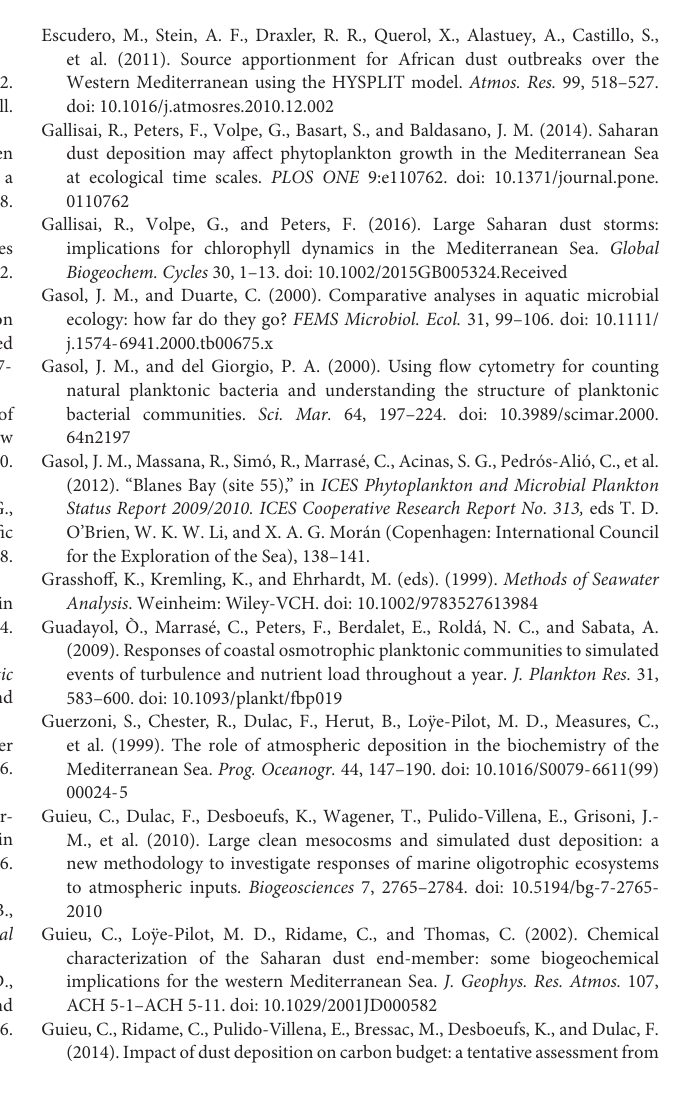
FIGURE S1 | Changes in the excitation (Ex)–emission (Em) matrixes of FDOM after the aerosol addition in the six experiments. The value of florescence before the addition in all the microcosm – expressed in quinine sulfate units (QSU) – is the same than in the C, whereas A and S matrixes show the values after the additions. The different peaks are indicated: Peak-C (terrestrial-like substances), Peak-M (marine-like substances), Peak-A (generic humic-like substances), and Peak-T (280 nm/420 nm) (protein-like substances). In the WI experiment there were no Saharan microcosms but A particles with different composition (A1 and A2) were added to two duplicate microcosm each. TABLE S1 | Aerosol-induced ratios (AIR) of the biogeochemical variables studied (abbreviations as in the main text). TREAT, TREATMENT (A = anthropogenic, S = Saharan); FILT, filtration (F = samples filtered by 0.8 µ m; NF = not filtered); WI, winter; SP, spring; SU, summer; BCN, Barcelona; BLA, Blanes; OFF, offshore. A dash indicates that the ratio could not be